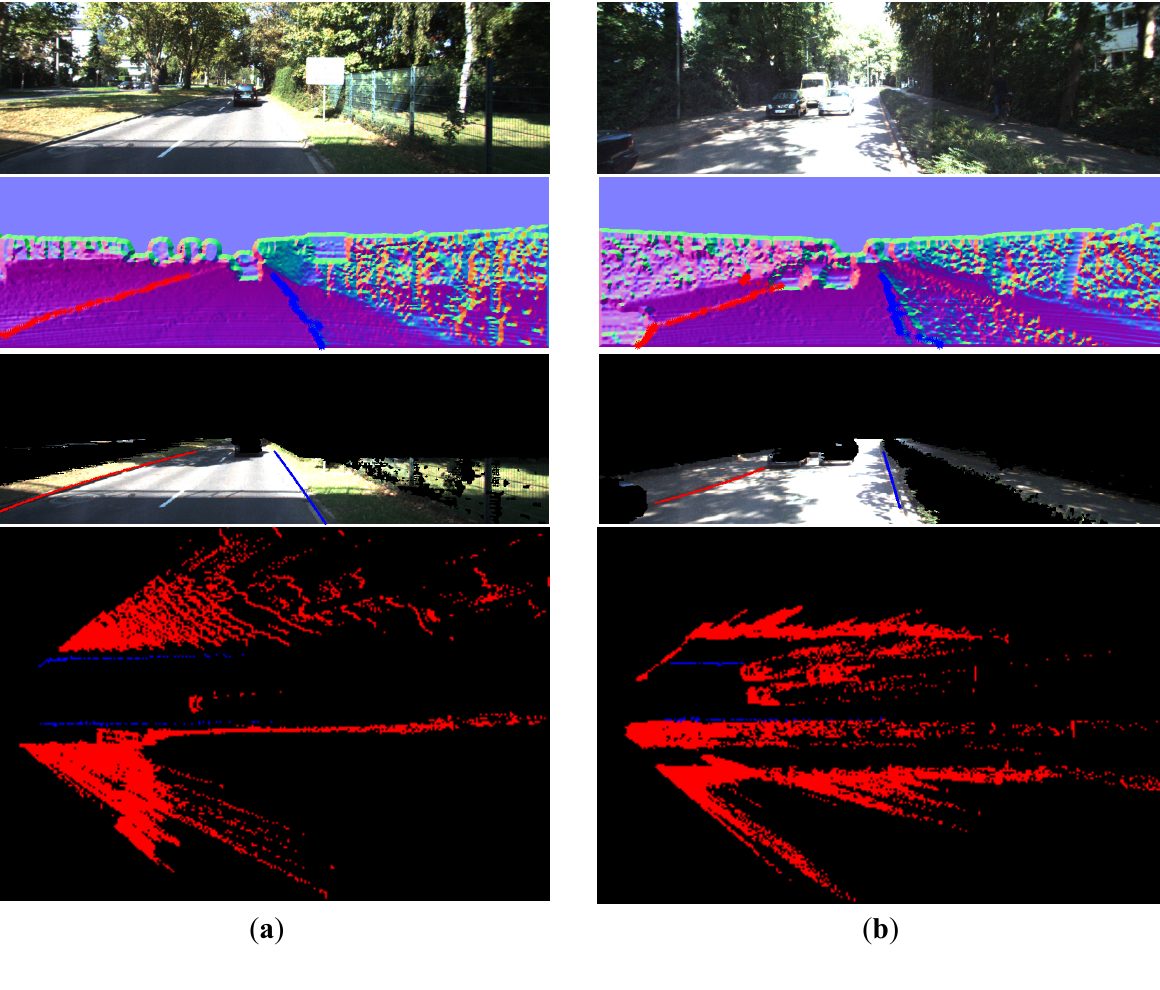
Figure 16. ( a ) Curbs in illumination change; ( b ) Curbs in strong shadow and with obstacle